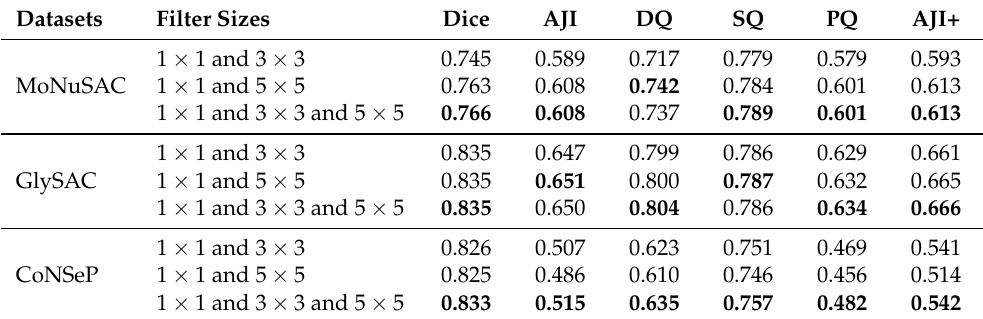
Table 4. Results of ablation experiments on cell